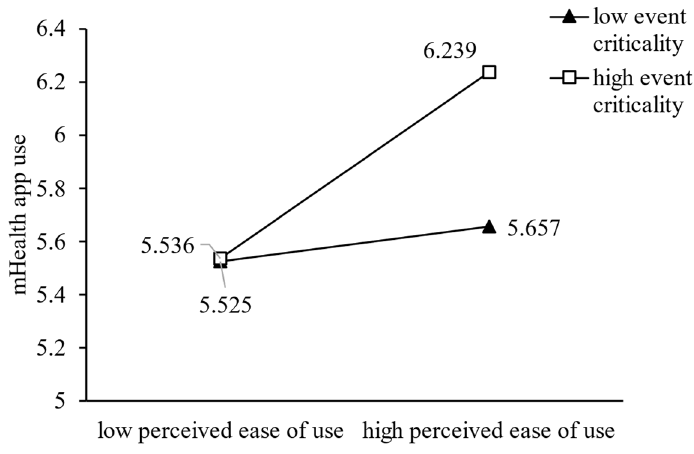
Figure 4. The Moderating Effect of Event Criticality on Perceived Ease of Use.